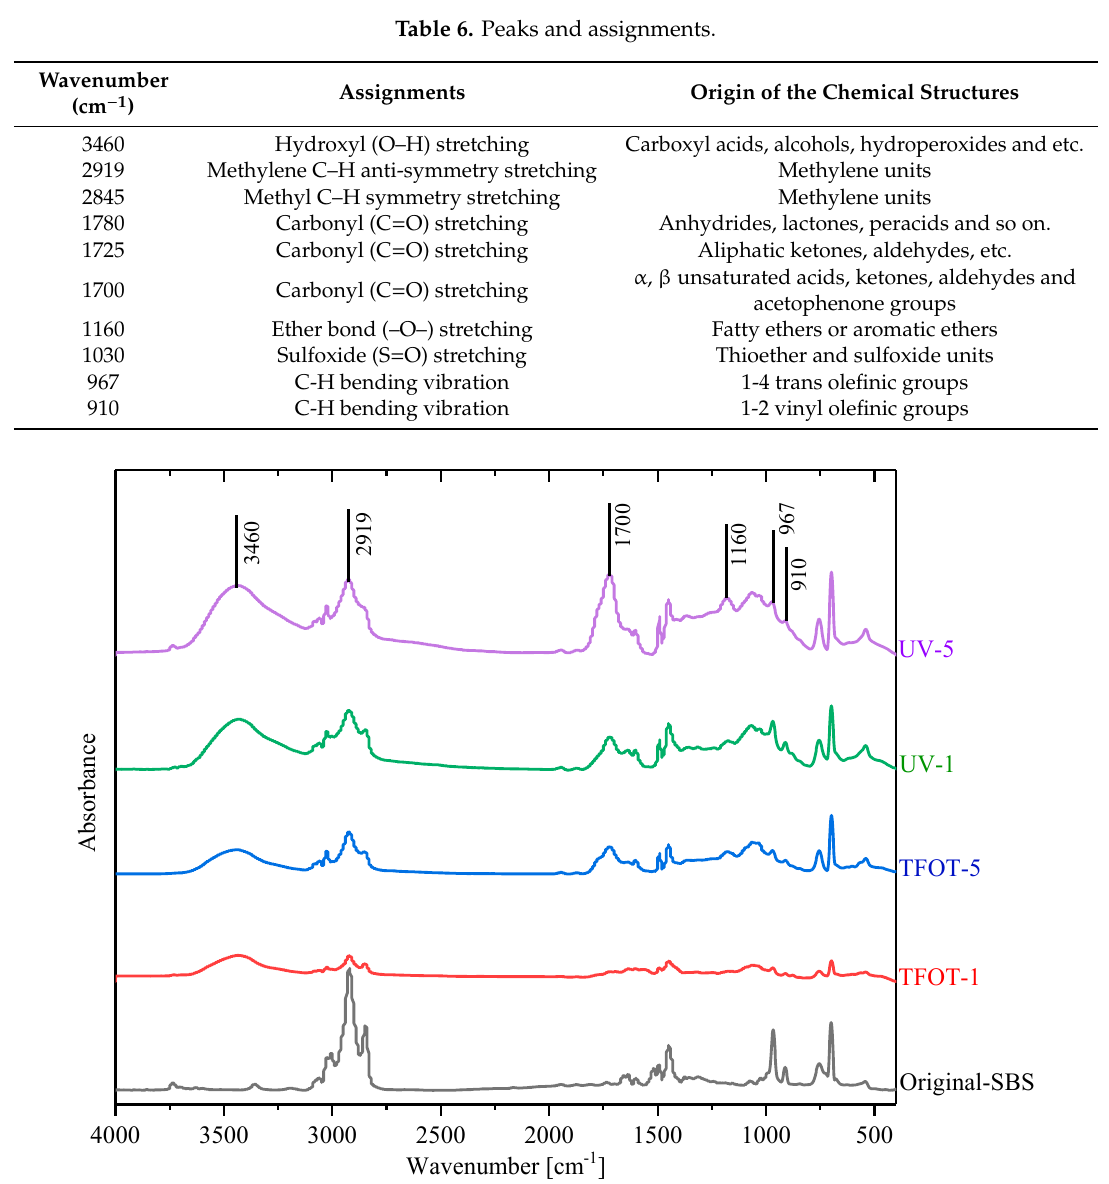
Figure 8. The spectra of aged copolymers.